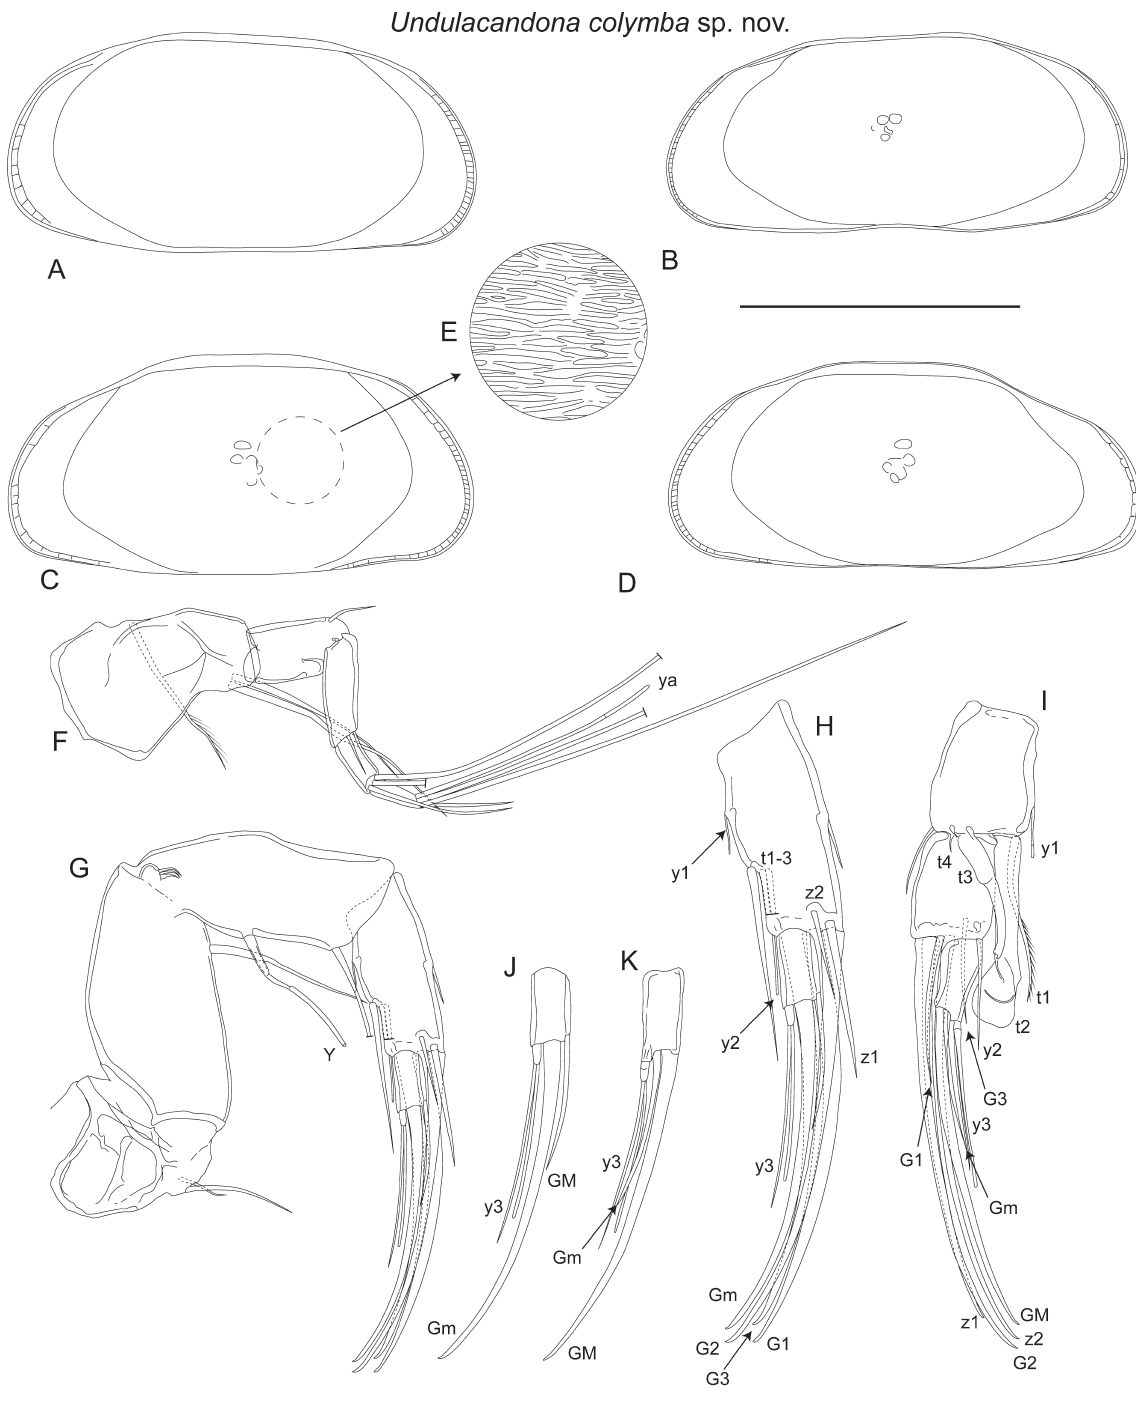
Fig. 15. Undulacandona colymba sp. nov. A . Internal view of male left valve (LBM 1430006279). B . Internal view of male right valve (LBM 1430006283). C . Internal view of female left valve (LBM 1430006280). D . Internal view of female right valve (LBM 1430006280). E . Detail of external surface of female right valve. F . Female antennule (LBM 1430006280). G . Female antenna (LBM 1430006280). H . Detail of female antenna (LBM 1430006280). I . Detail of male antenna (LBM 1430006279). J . Detail of female’s final antennal segment (LBM 1430006280). K . Detail of female’s final antennal segment. Scale bar: A–D = 464 µm; E = 232 µm; F–G = 117 µm; H–K = 92